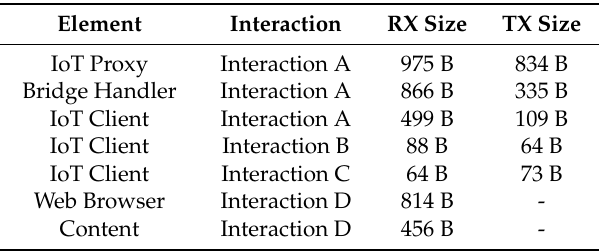
Table 2. Network packet sizes of